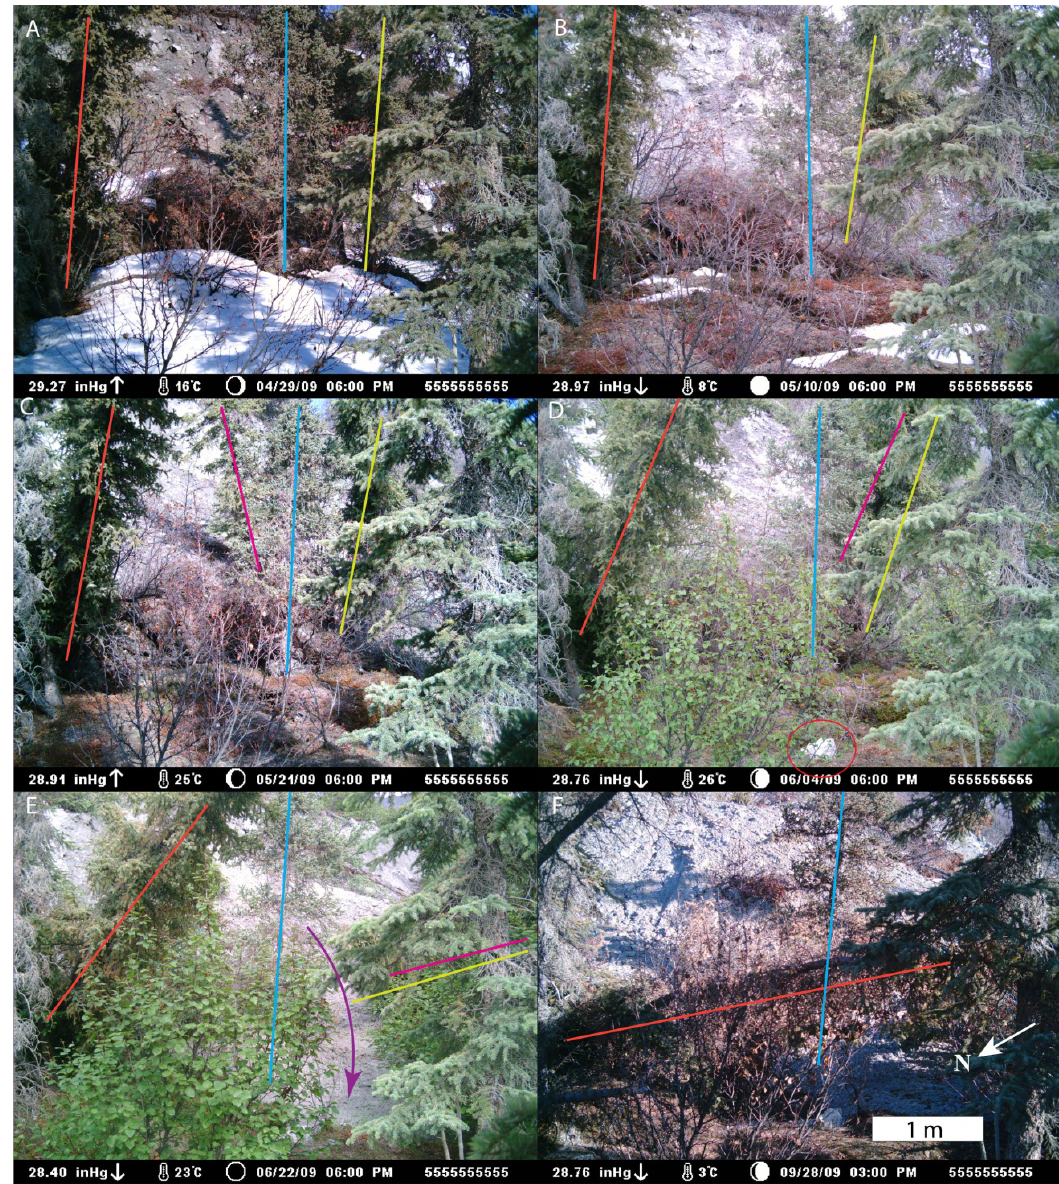
Fig. 10. Repeat photography of a portion of the FDL-A terminus. The steep face slumps down as it saturates during rain events. Straight lines follow positions of individual trees in the images (magenta tree fell from the top of the terminus); the red circle indicates the appearance of a rock from upslope; the purple arrow indicates mud flow from the steep slope. Photographs were selected from 29 April to 28 September 2009. surface sediment samples from FDL-A, which included fist- sized, tabular clasts of biotite garnet schist and quartz. Grain size analysis was performed for the sediment fraction smaller than 75 mm. The two samples were classified as silty sand with gravel and silty gravel with sand (GM), according to the Unified Soil Classification System (Fig. 8). The sediment from these samples had a specific gravity of 2.79, a liquid limit of 32 and no plastic